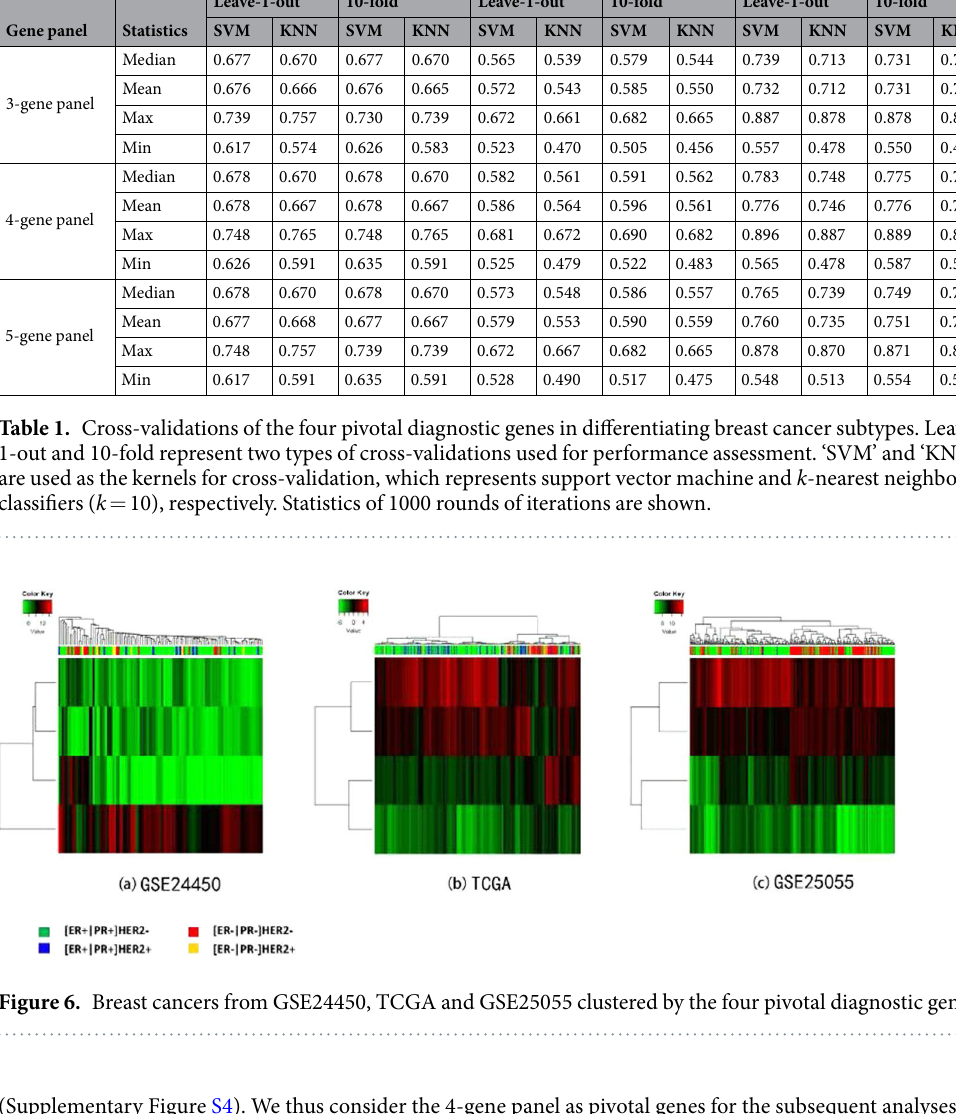
Diagnostic genes. C-score and the p-value decreases and increases dramatically from the 6 th enriched pathway (Supplementary Figure S5). The top five pathways are ‘CDK regulation of DNA replication’ (p = 7.15E-05, C-score = 14.54), ‘downregulation of MTA3 in ER-negative breast tumors’ (p = 7.15E-05, C-score = 11.11), ‘role of HER2 in sig- nal transduction and oncology’ (p = 5.37E-03, C-score = 8.72), ‘cyclines and cell cycle regulation’ (p = 4.52E-03, C-score = 6.07) and ‘role of Ran in mitotic spindle regulation’ (p = 1.33E-03, C-score = 5.85) (Table 2). Three out